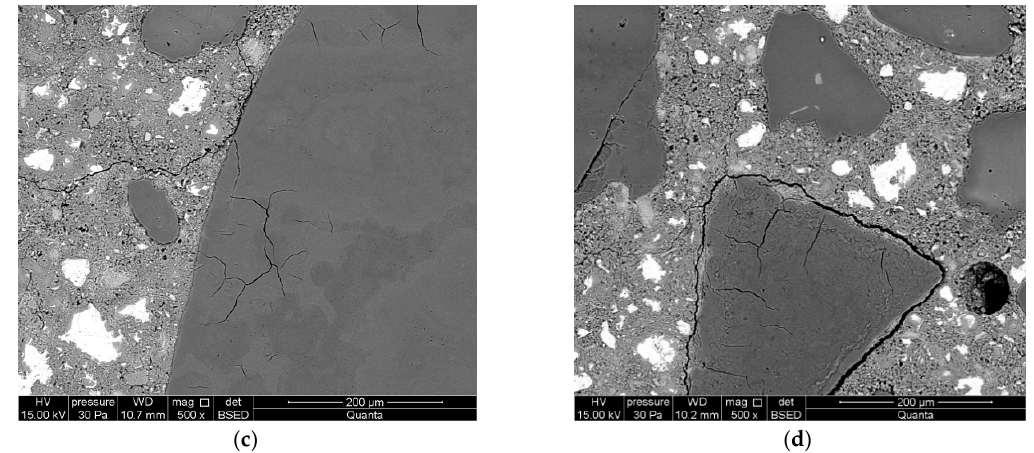
Figure 6. Microstructure of mortars with lithium nitrate, analyzed along with the progress of the reaction after: ( a ) 1 day; ( b ) 3 days; ( c ) 7 days; and ( d ) 14 days.